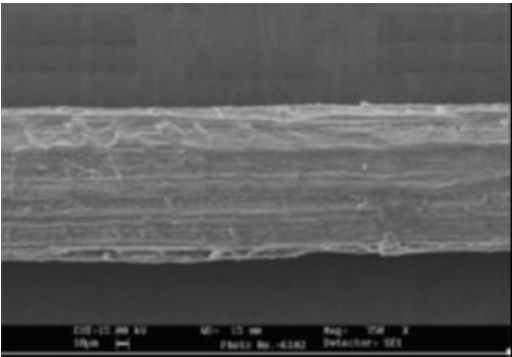
Figure 4. SEM micrograph 750x of untreated Curauá fibres.